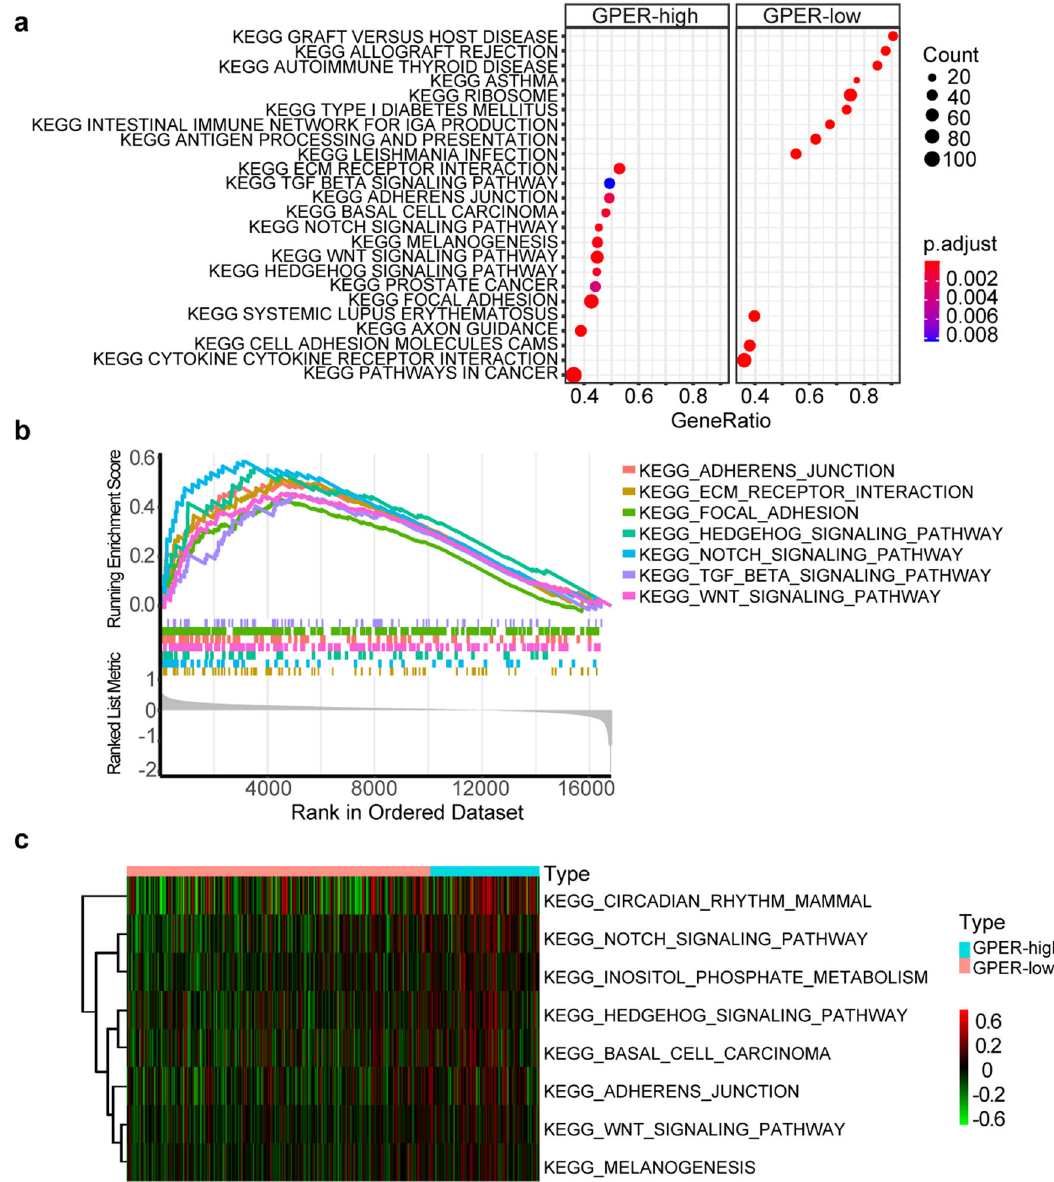
Fig. 5 The GSEA and GSVA results of GPER correlated pathways based on the transcriptomic data of 360 TNBC patients. a Dotplot showing the twelve most signi fi cantly upregulated pathways in GPER-high and GPER-low groups from GSEA results. In the group of high GPER expression, seven of the twelve upregulated pathways are correlated with promoting tumor metastasis. b GSEA-plots showing the upregulated pro-metastatic pathways in the GPER-high group. c Heatmap for the eight most signi fi cantly upregulated pathways in GPER-high group by GSVA. Statistically signi fi cant differences were de fi ned as adjusted P -value <